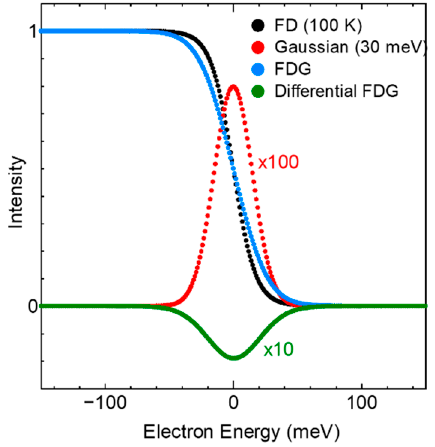
Figure 1. FD distribution of 100 K (black), Gaussian function with a width of 30 meV (red); en- larged100 times and 10 times, respectively.